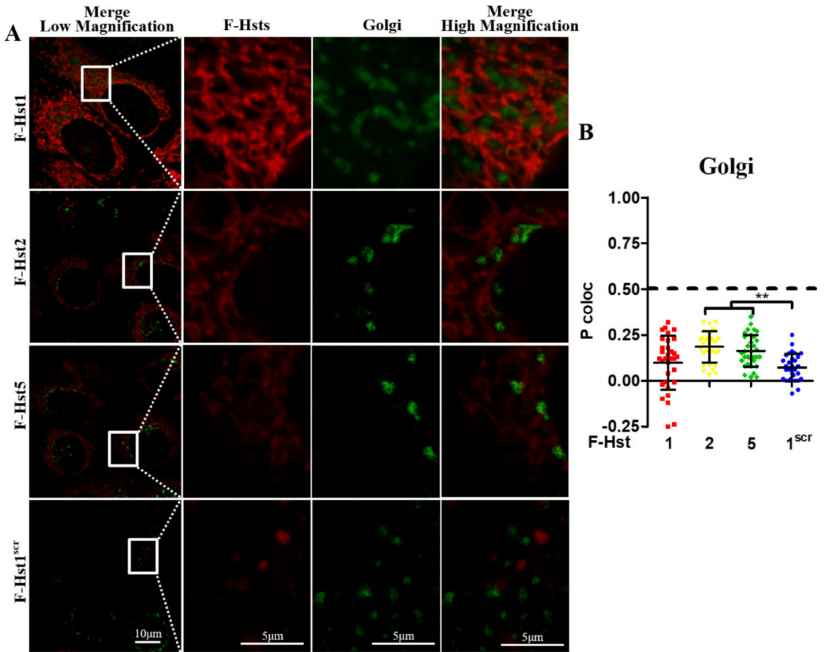
Figure 5. F-Hst1, F-Hst2 and F-Hst5 were not targeted to Golgi. ( A ) CLSM images showed neither F-Hst1, F-Hst2 F-Hst5 nor F-Hst scr (in red) showed a co-localization with Golgi (in green). ( B ) The Pearson’s correlation analysis also confirmed that none of F-Hst1, F-Hst2 F-Hst5 or F-Hst scr co-localized with lysosomes (P coloc value below 0.5). Data were presented as mean ± SD. **: p < 0.01.